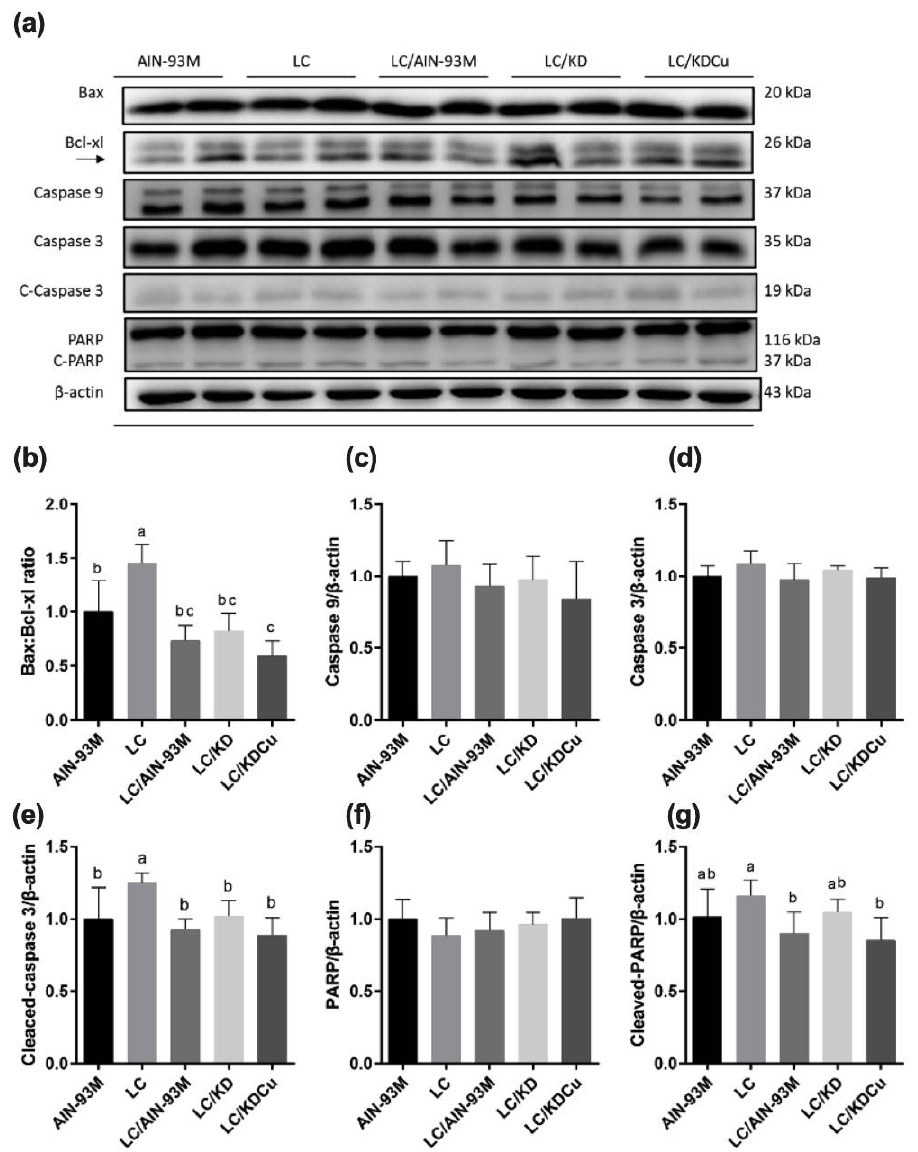
Figure 8. Effects of the low carbohydrate diet and curcumin on testicular intrinsic apoptosis pathway regulators ( a ) protein expressions in each group ( b ) Bax:Bcl-xl, ( c ) caspase 9, ( d ) caspase 3, ( e ) cleaved-caspase 3, ( f ) PARP, ( g ) cleaved-PARP in male mice. Data are expressed as means ± SD. n = 6–9 per group. Bars (a, b, c) with different letters indicate that values are significantly different. (One-way ANOVA, Duncan’s test, p < 0.05). AIN-93M: AIN-93M diet; LC: low carbohydrate diet; LC/AIN-93M: low carbohydrate diet changed to AIN-93M diet; LC/KD: low carbohydrate diet changed to ketogenic diet; LC/KDCu: low carbohydrate diet changed to ketogenic diet and curcumin.